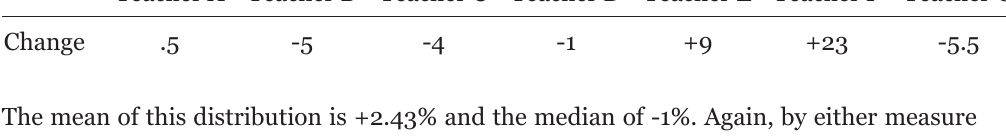
Change in CRT Scores for Teachers Using Open Textbooks Comparing 2009–2010 Aver- age Scores with 2011